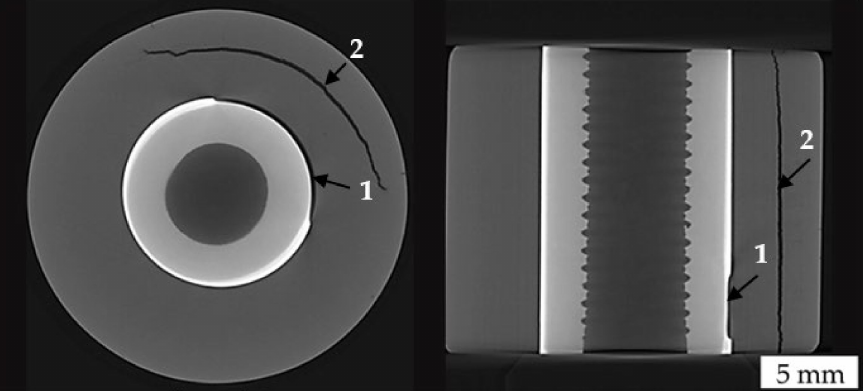
Figure 7. Horizontal and vertical cross-sectional views of a non-sputtered and unmilled specimen showing a non-brazed area (1) and a large crack (2) after